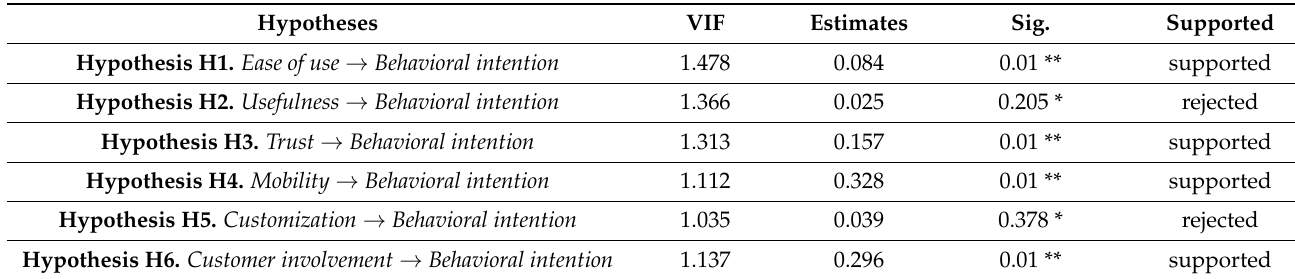
Table 6. Hypotheses